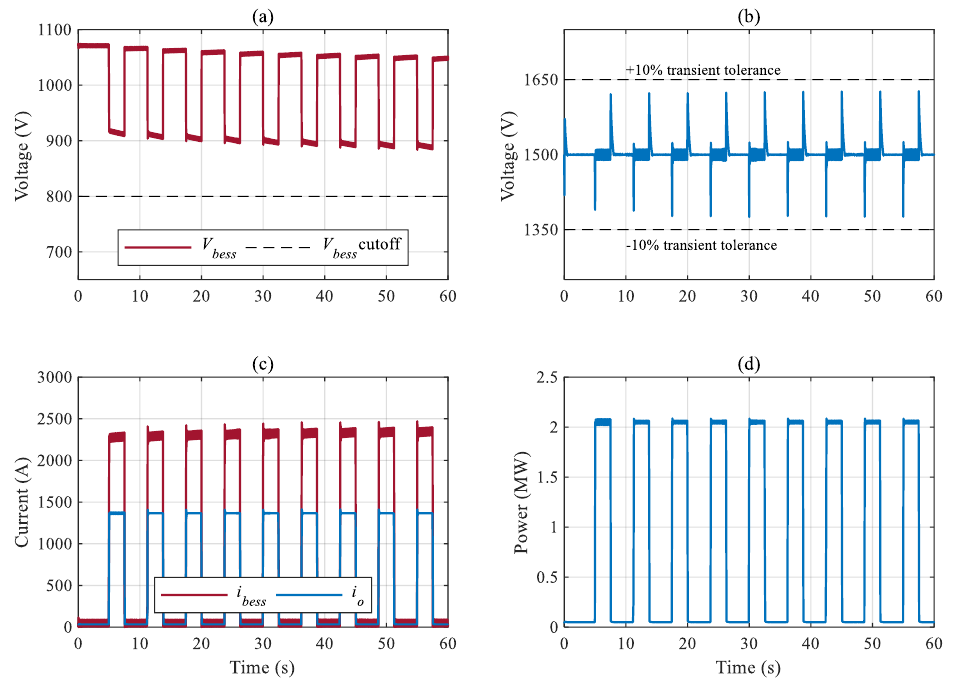
Figure 7. Simulated ( a ) battery voltage ( b ) converter output voltage, v o ( c ) current and ( d ) LDEW power response when the battery commences 2 MW, 25 ms rise time LDEW pulse load at 40% duty cycle at 90% SoC.